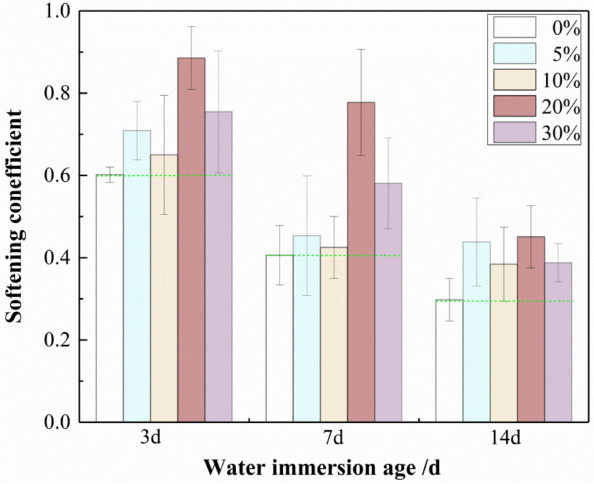
Figure 4. The softening coefficient of MOC with different contents of lithium